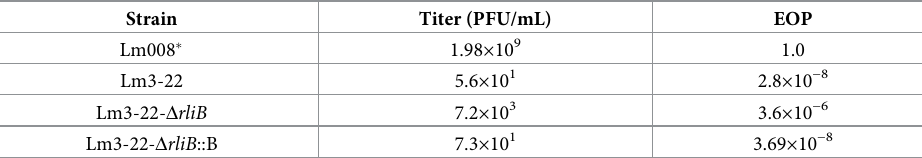
EOP were detected by phage vB-LmoM-SH3-3. Phages were reacted with Lm008, Lm3-22- Δ rliB , Lm3-22 and Lm3- 22- Δ rliB ::B, respectively. The titers of phage vB-LmoM-SH3-3 from different host bacteria were determined, respectively. The EOPs were calculated by ratio of tested strain to reference strain and determining the average for three independent assays. � Lm008 as reference strain.